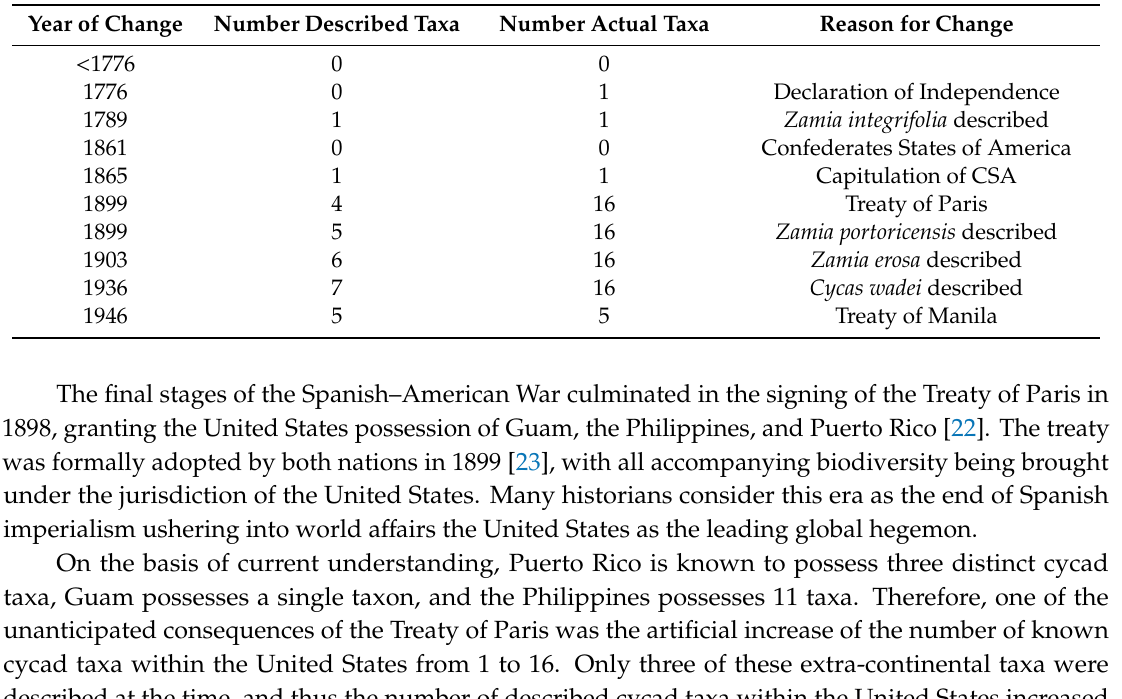
Table 1. ThecontemporarycycadspecieswithintheUnitedStatesasinfluencedbyhistoricaltreaties /